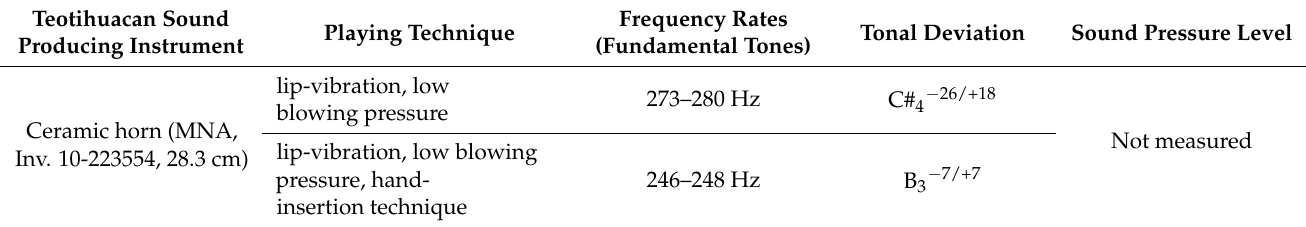
Table 2. Acoustic data sheet of the ceramic horn (MNA, Inv.